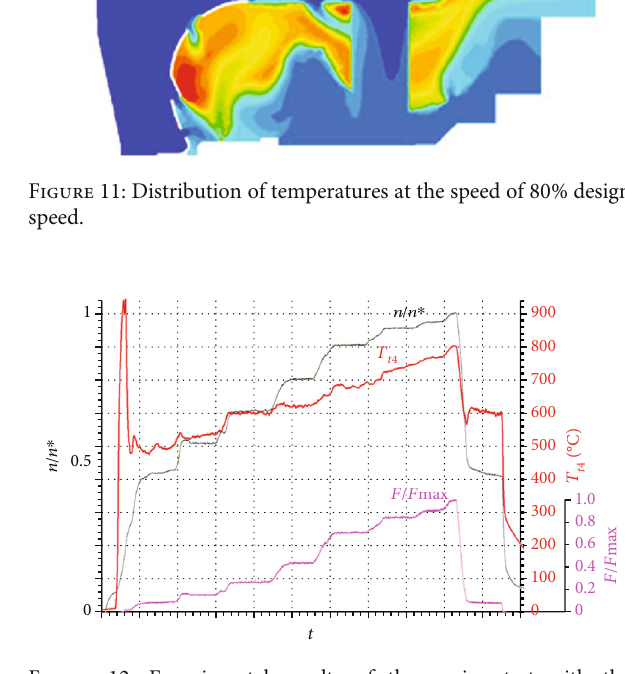
Figure 12: Experimental results of the engine test with the optimized combustor.